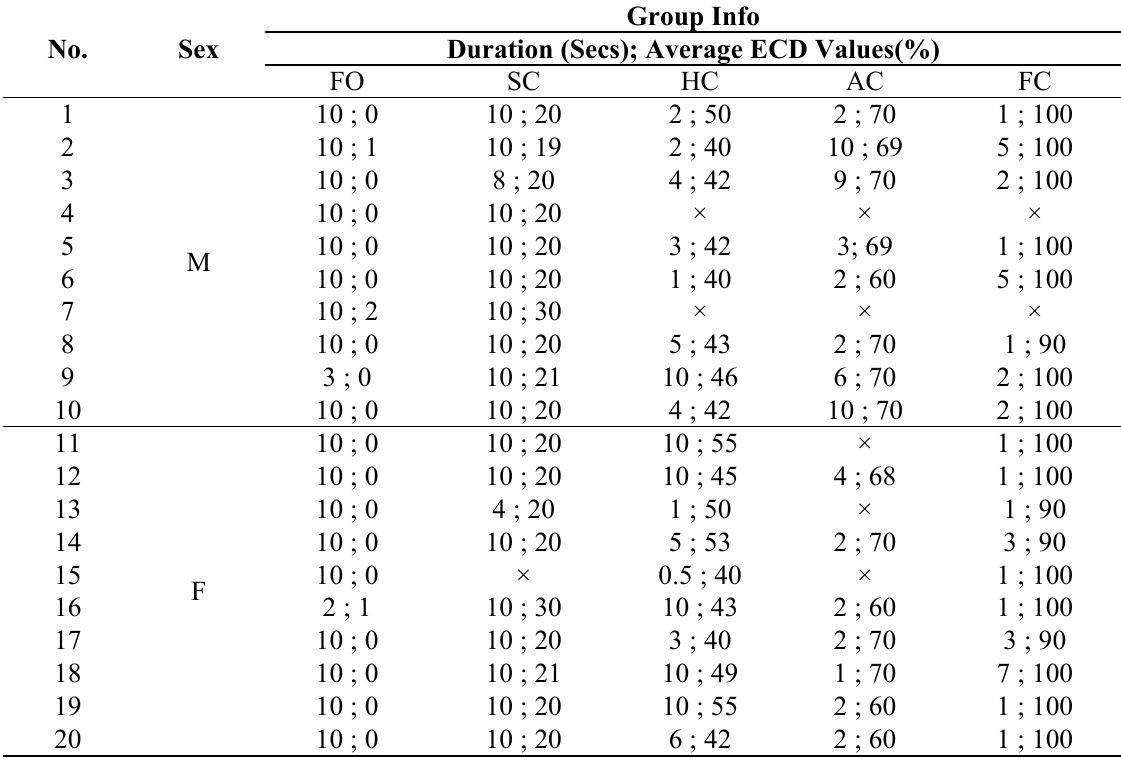
Table 4. Summary of the extracted ECD